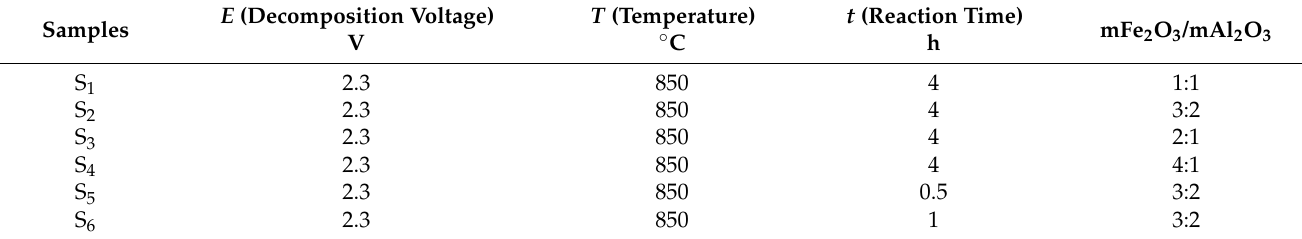
Figure 1. Schematic illustration of the electrochemical deoxidation strategy of Fe 2 O 3 /Al 2 O 3 . Table 1. Specific experimental conditions in electrochemical deoxidation.